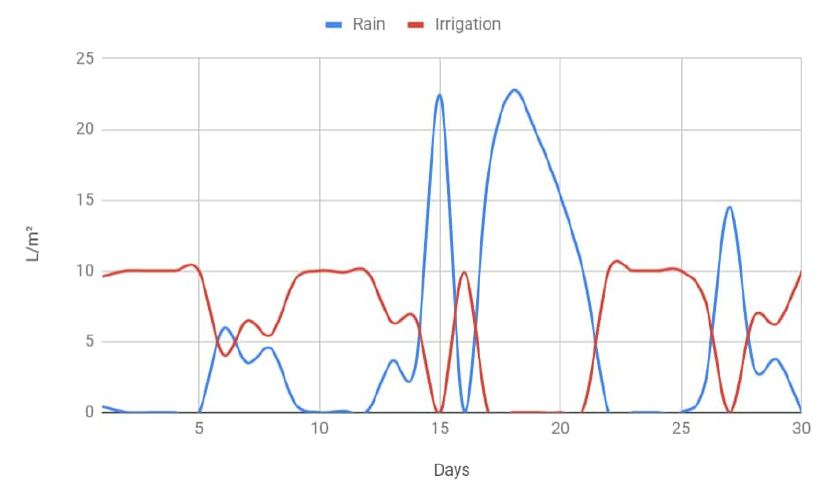
Figure 7. Estimated irrigation per day during the month of September 2020 when depending on rain